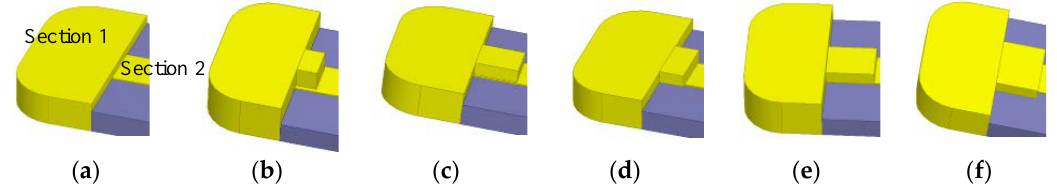
Figure 8. ( a ) ideal. ( b ) (50,80,50). ( c ) (100,90,30). ( d ) (60,120,50). ( e ) (120,100,30). ( f ) (110,150,30).